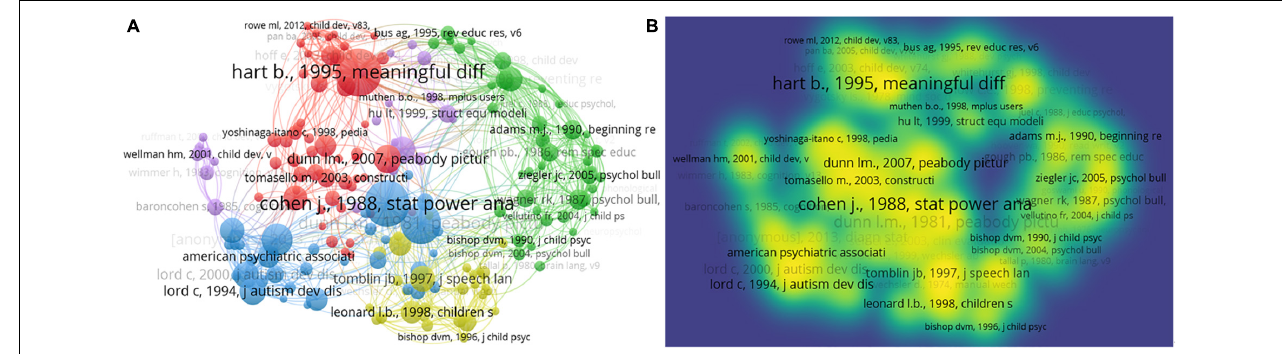
FIGURE 14 | Reference co-citation networks of CL were based on citation weights. (A) Reference co-citation network visualization; (B) reference co-citation density